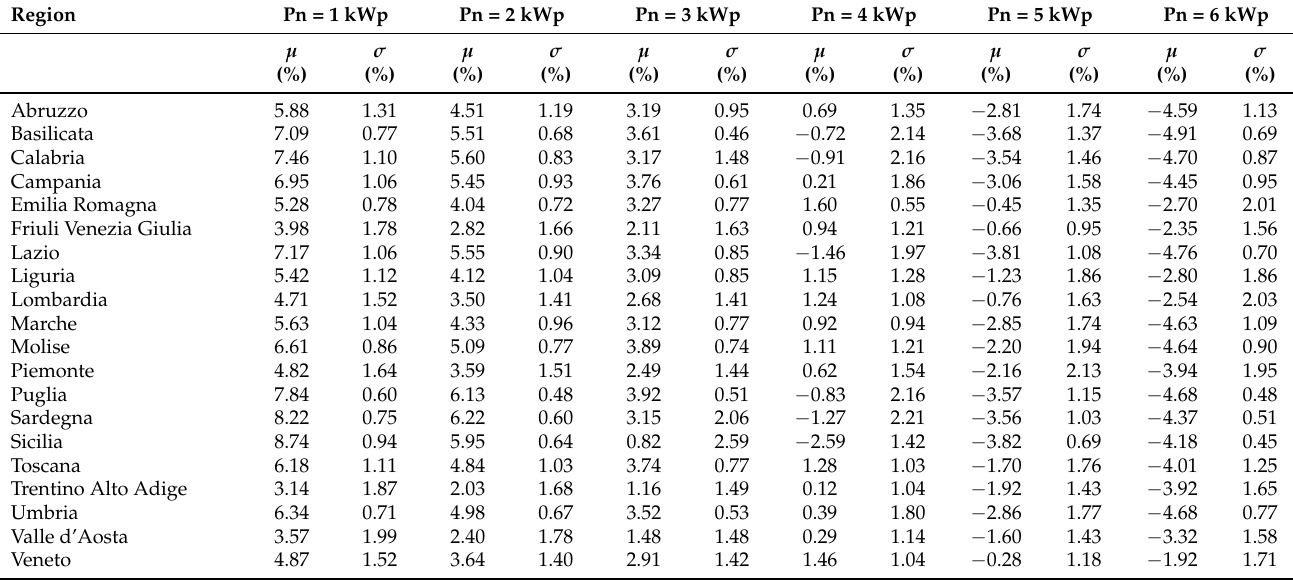
Table 28. IRR for E L = 4000 kWh with battery.